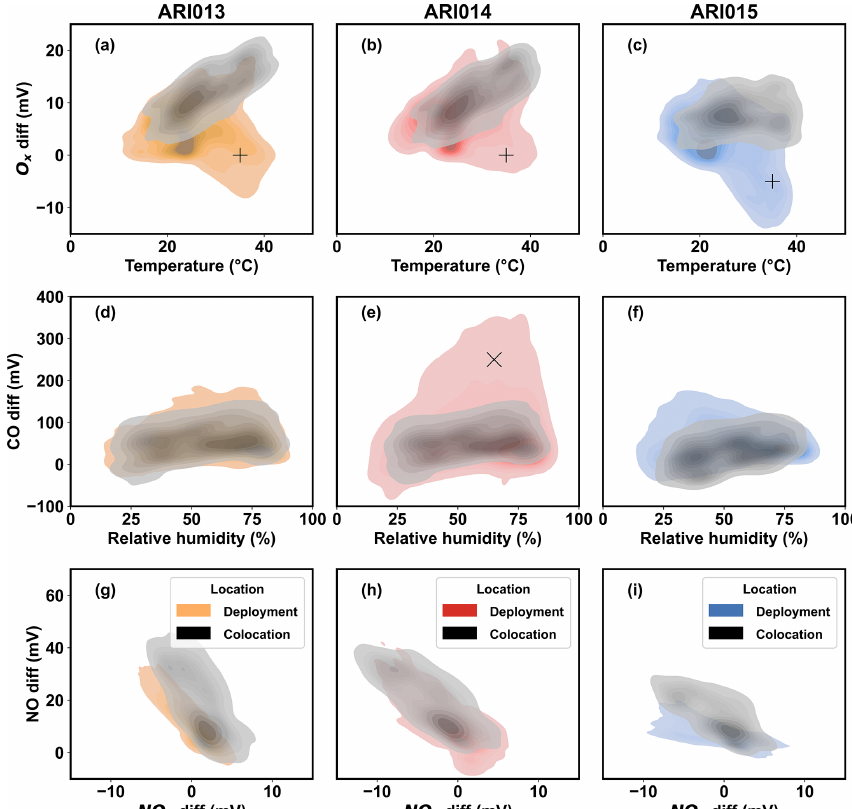
Figure 5. Bivariate distributions of gas sensor calibration model data inputs (RH; T ; and O x , CO, NO, and NO 2 differential voltage) for each ARISense monitor using kernel density estimation. Density is reflected in the color scheme, where darker colors indicate more data points in that region. Training data collected during colocation in North Carolina are shown in grey, and data collected during deployment to Malawi are shown in color. ARI013 was deployed to the Village 2 site, ARI014 to the Village 1 site, and ARI015 to the University site. Regions where the deployment distributions overlap with the NC colocation distributions indicate the regimes for which the calibration models were trained. Regions where the deployment location distributions extend beyond the NC colocation distributions indicate regimes where the calibration models must extrapolate to estimate pollutant concentrations. These regions are indicated by overlaid markers “x” and “ + ” and are discussed in the